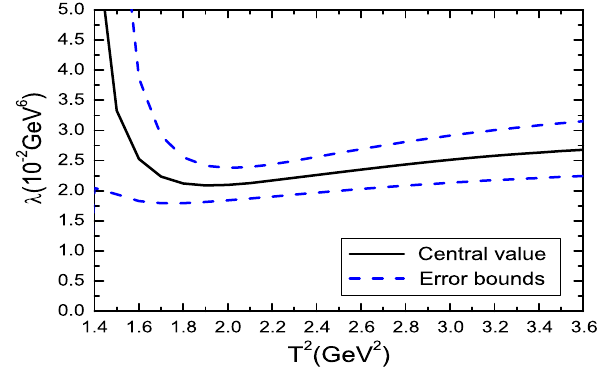
Fig. 1 ThepolecontributionswithvariationoftheBorelparameter T 2 , where the A , B and C denote the threshold parameters 4 . 8GeV and 4 . 9GeV, respectively